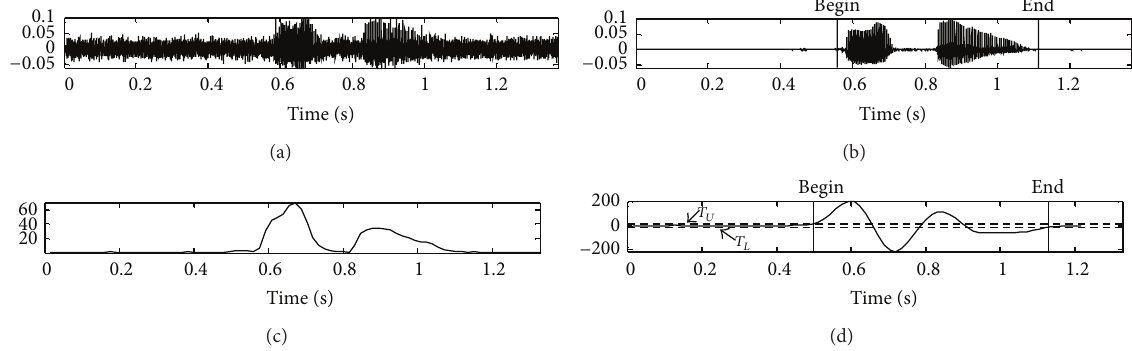
Figure 8: Results of the proposed algorithm in an exhibition hall - noise environment: (a) noisy speech signal at SNR − 5dB, (b) clean speech signal, (c) the proposed feature, and (d) edge detection filter output based on the proposed